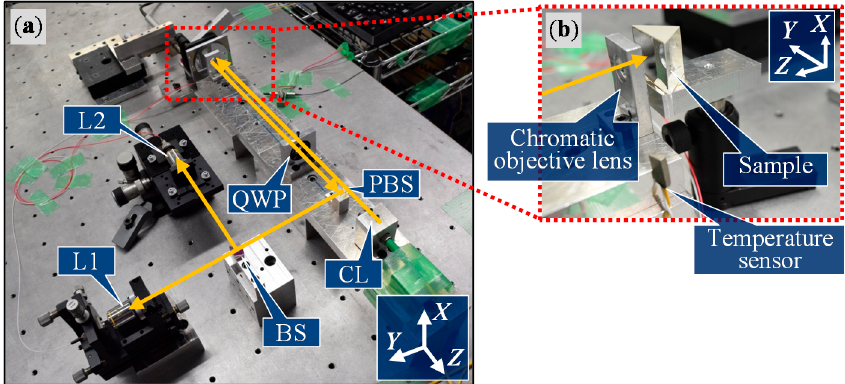
Figure 2. Photograph of the first prototype chromatic confocal measurement setup: ( a ) Photograph of the overall chromatic confocal measurement setup; ( b ) Photograph of the sample unit composed of a sample and sample jigs. (CL: Collimating lens, BS: Beam splitter, PBS: Polarized beam splitter, QWP: Quarter-wave plate, L1 and L2: Fiber coupling lenses).